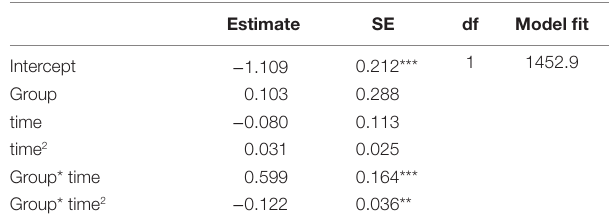
TaBle 3 | Model estimates the amount of job regarding different measurement